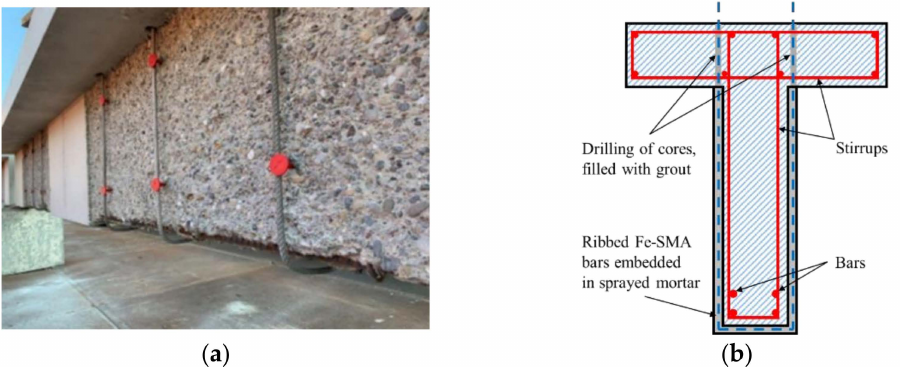
Figure 14. Shear reinforcement with Fe-SMAs embedded in sprayed mortar layer (adapted from [111]): ( a ) installed memory-steel stirrups on-site; ( b ) cross-section of reinforced